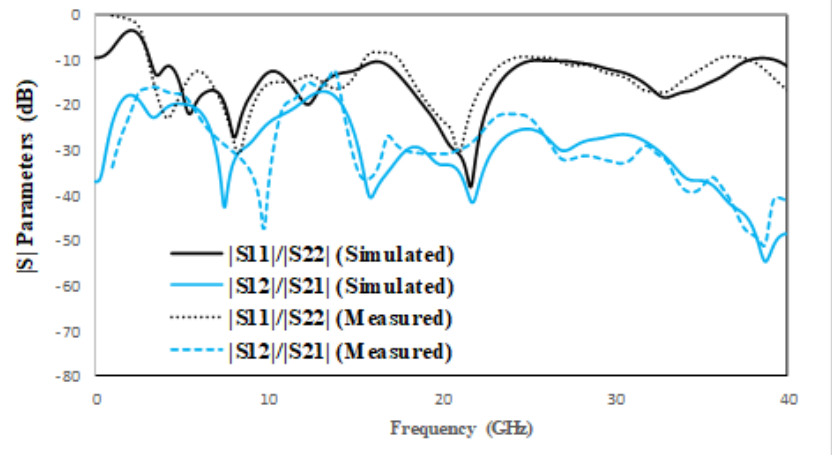
Figure 7. Measured and simulated | S | parameters of proposed MIMO